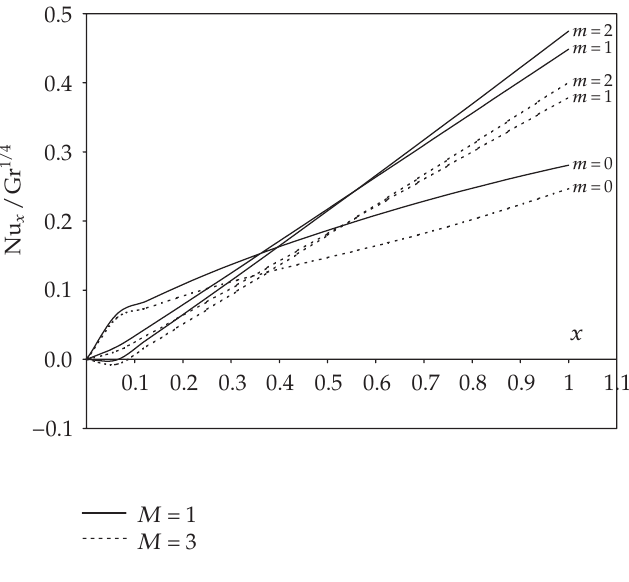
Figure 5.17 . The e ff ect of M and m parameters on local Nusselt number at F = 0 . 01 and Pr = 0 .